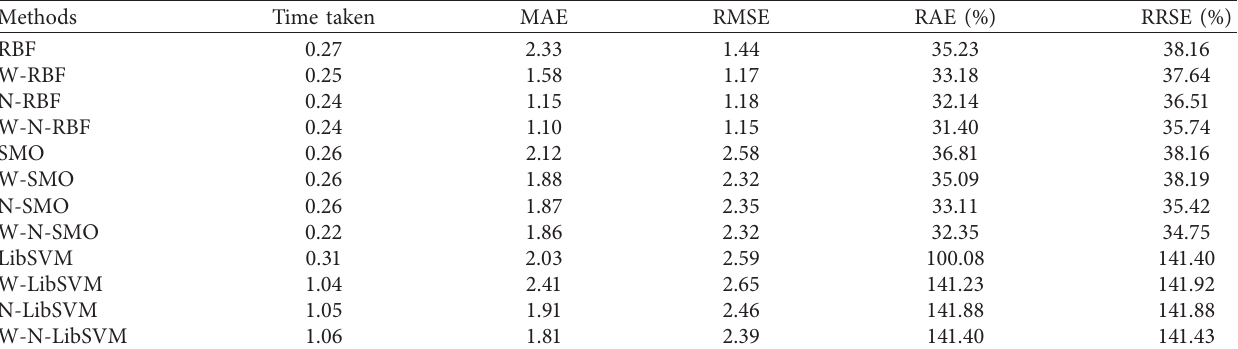
Table 3: Comparison of errors and time taken for minimum temperature,